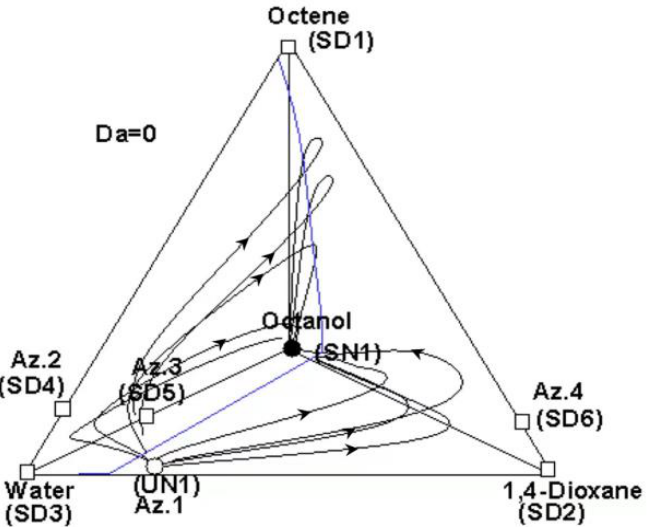
Figure 8. Residual curve plot of 1-octene hydration reaction quaternary system (1 atm).